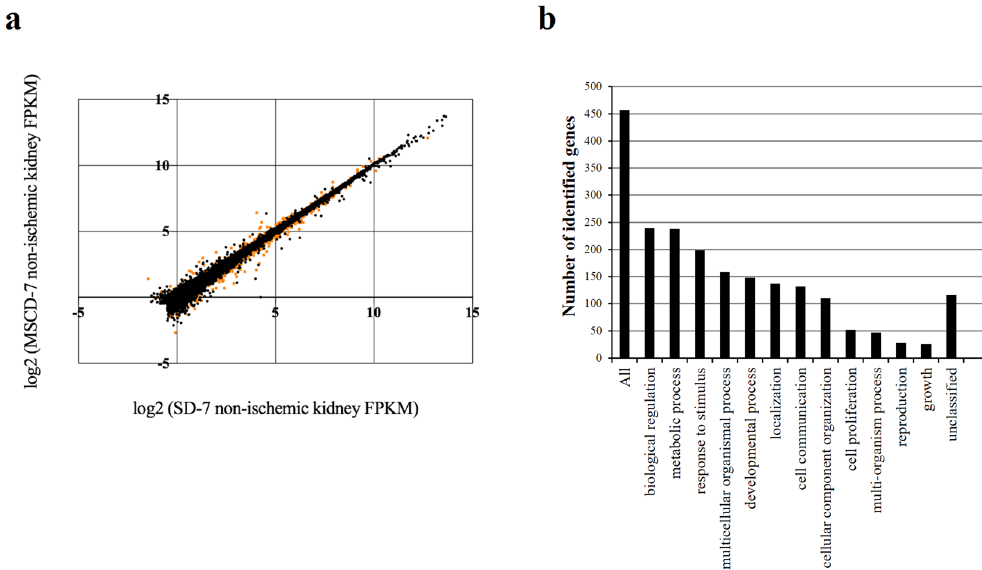
Figure 3. Illumina high-throughput RNA sequencing and Gene Ontology slim classification analyses. ( a ) Differential gene expression analysis obtained with BaseSpace ® Cufflinks Assembly. Scatter plot of the log2 (Fragments per Kilobase of sequence Per Million mapped reads, FKPM) counts of genes for control (SD − 7) and MSC-treated (MSCD − 7) non-ischemic kidneys. Dots represent the 25908 genes differentially assessed, with orange dots corresponding to the significantly differentially expressed genes (False Discovery Rate (FDR), < 0,05). ( b ) Gene Ontology classification for biological processes of the significantly differentially expressed genes successfully mapped to a gene symbol (WEB-based GEne SeT AnaLysis Toolkit).